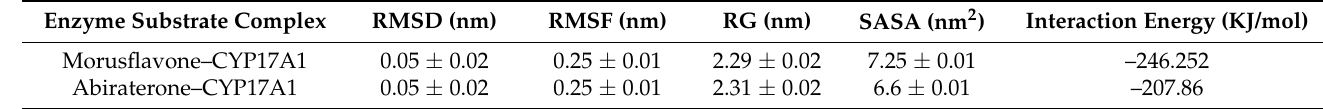
Figure 5. Pictorial presentation of SASAs. Morusflavone is represented by black and abiraterone by red. Table 2. Stability analysis of